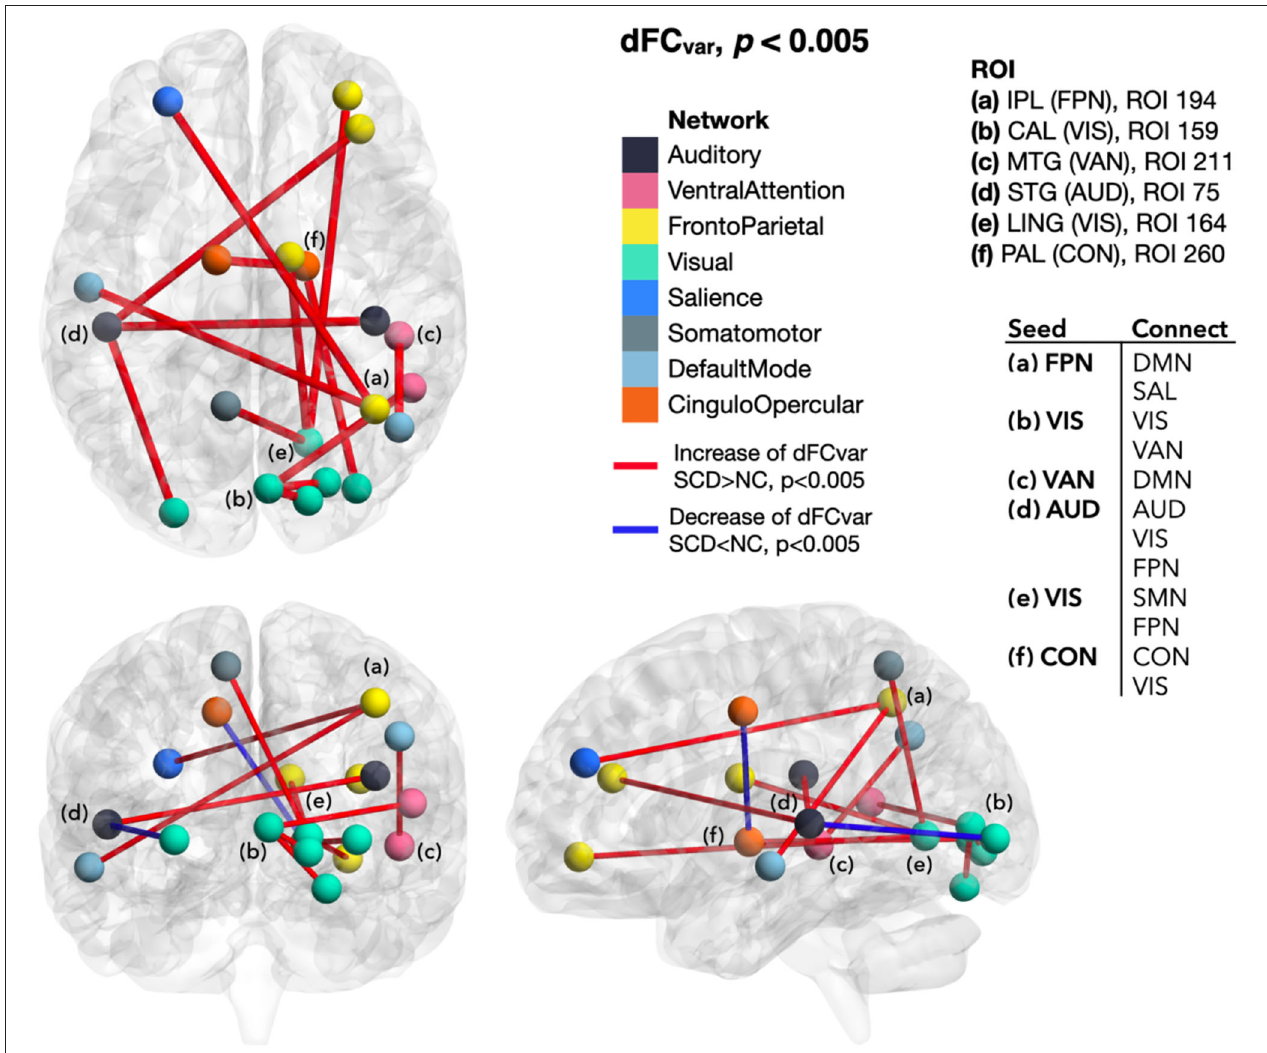
FIGURE 5 | Differences of dFC var between SCD and NC. In SCD, dFC var generally increased from the ROIs with local dynamic connectivity changes (seeding ROIs) to other brain regions. In contrast, the dFC var decrease appeared between the ROIs of AUD-VIS and within CON. dFC var , variance of the dynamic functional connectivity; SCD, subjective cognitive decline; NC, normal control; ROI, region of interest; IPL, inferior parietal lobule; FPN, frontoparietal network; CAL, calcarine area; VIS, visual network; MTG, middle temporal gyrus; VAN, ventral attention network; STG, superior temporal gyrus; AUD, auditory network; LING, lingual gyrus; VIS, visual network; PAL, pallidum of lenticular nucleus; CON, cingulo-opercular network; DMN, default mode network; SAL, salience network; SMN, somatomotor